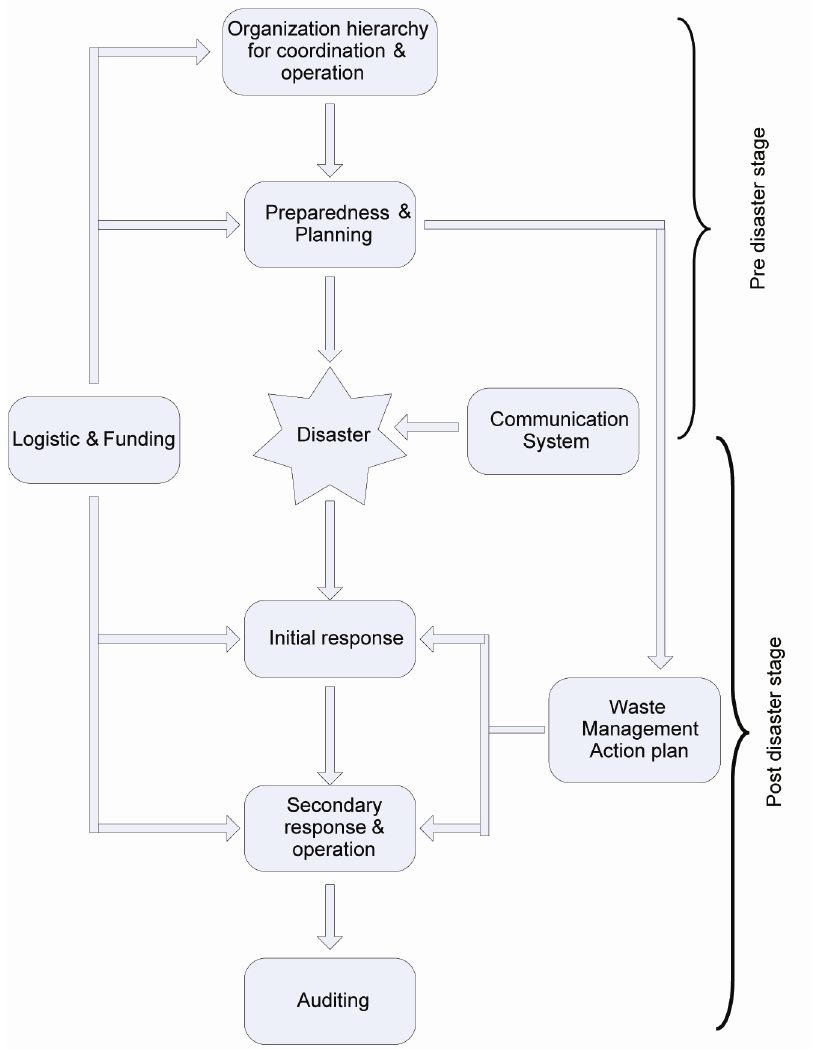
Fig. 3. Framework for post-disaster C&D debris